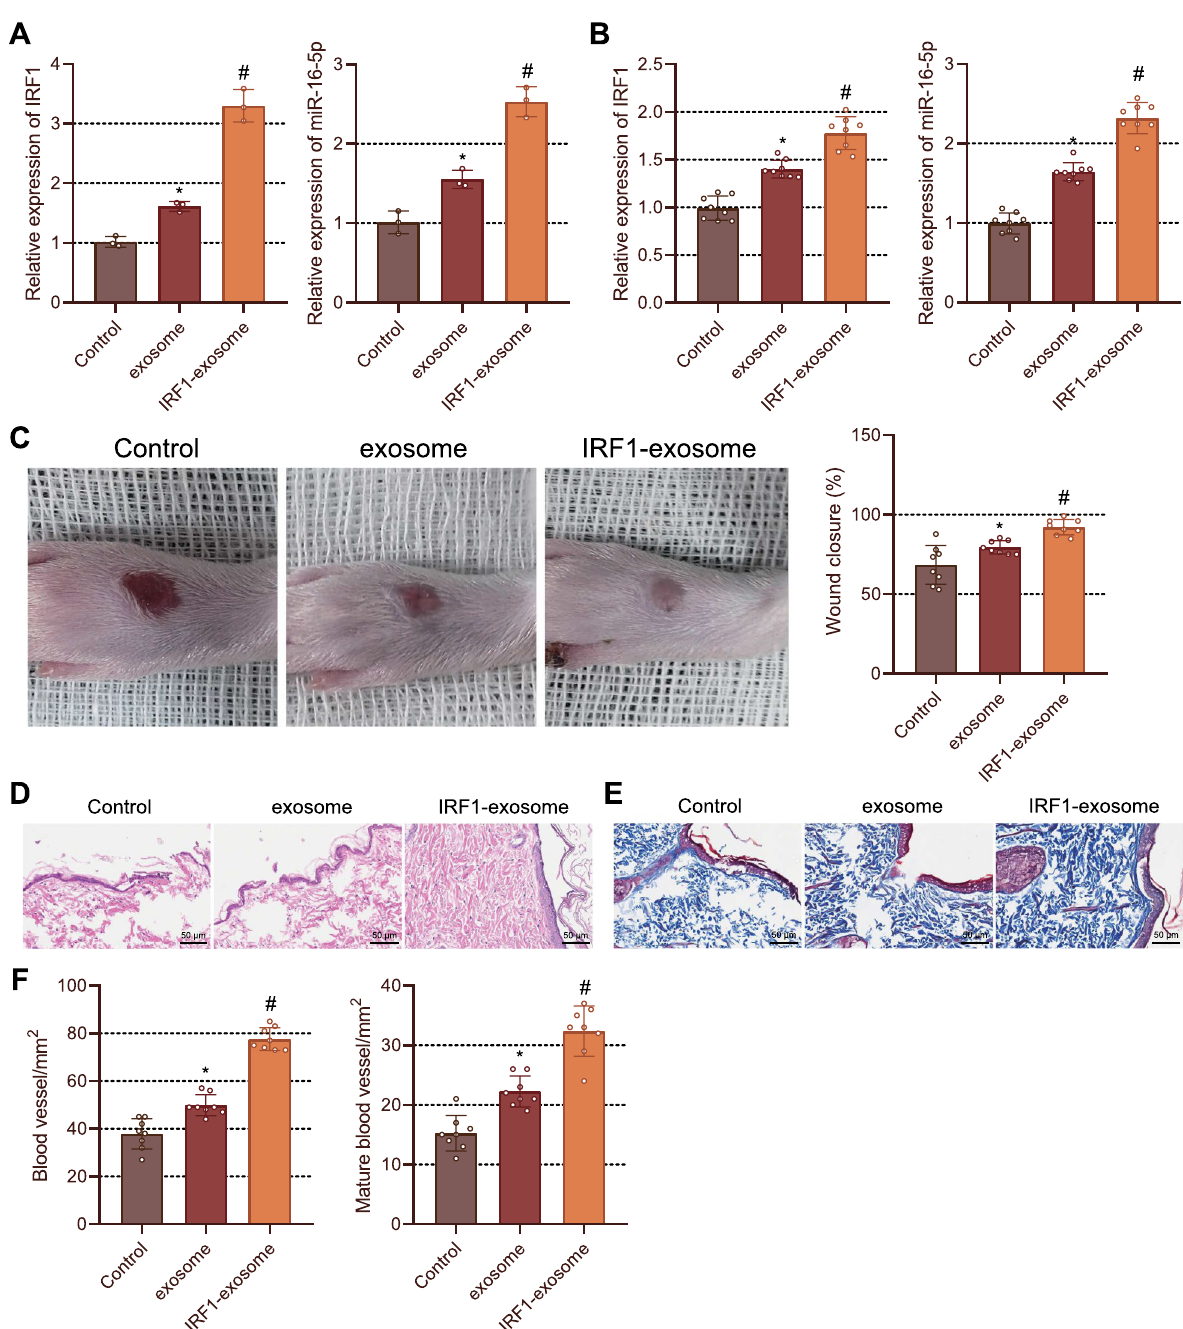
Fig. 6 IRF1 ‑ exosome facilitates wound healing in DM rats. A The expression of IRF1 and miR-16-5p in rASCs treated with exosomes or IRF1-exosome determined by RT-qPCR. B The expression of IRF1 and miR-16-5p in foot wound tissues of rats on day 14 determined by RT-qPCR. C Wound diameter changes in rats on day 14. D Morphological and structural changes of rat wound tissues observed on day 14 by HE staining. E Collagen deposition in the rat wound tissues analyzed on day 14 by Masson staining. F Quantitative analysis of newly formed (left) and mature (right) blood vessels in rat wound tissues on day 14. * p < 0.05 vs. PBS-treated DM rats. # p < 0.05 vs. exosome-treated rats. Cell experiments were repeated three times. n 8. Measurement data were presented as mean standard deviation. Data among multiple groups were compared by = ± one-way ANOVA, followed by Tukey’s post hoc test for multiple